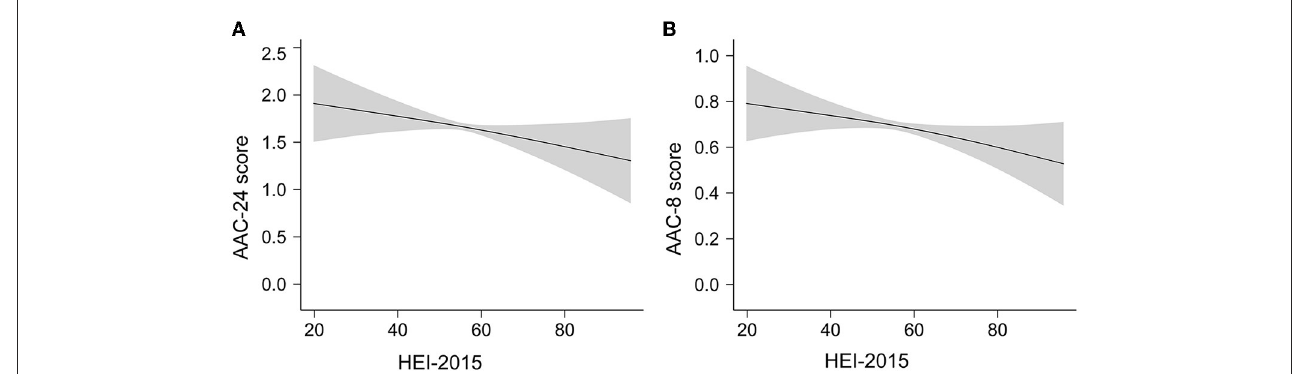
FIGURE2 The linear dose–response relationship between HEI-2015 and AAC score by GAM. The shaded areas represent 95% confidence intervals. (A) The linear relationship of HEI-2015 with AAC-24 score. (B) The linear relationship of HEI-2015 with AAC-8 score.